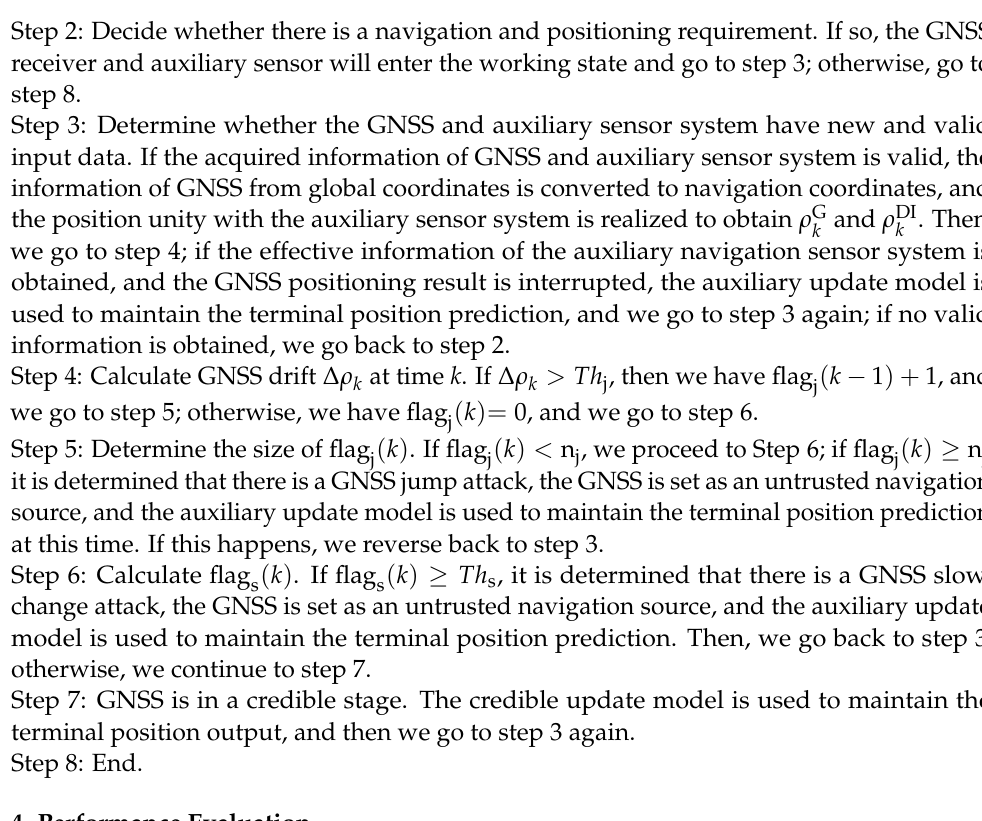
Table 2. Initial state parameters of the trajectory. Type